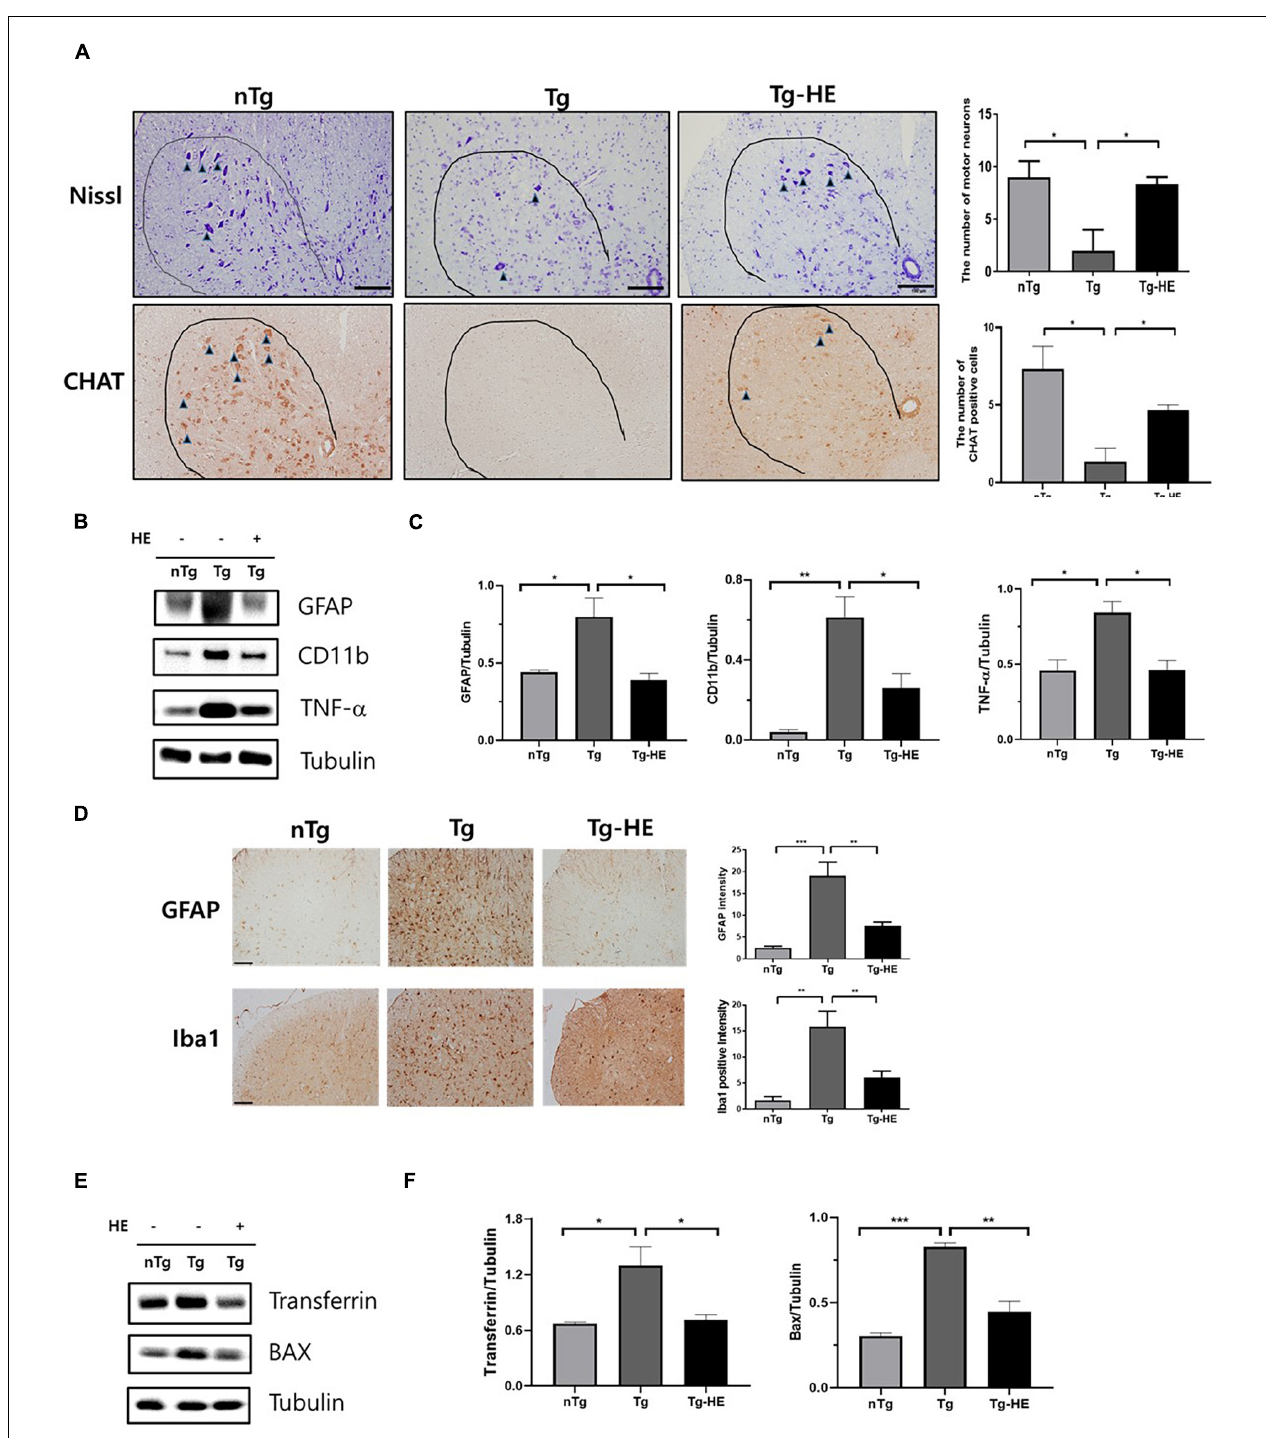
FIGURE 6 | Herbal extract (HE) inhibits motor neuron death and increases anti-neuroinflammatory and anti-oxidative effects. (A) Nissl staining of the motor neurons (arrowheads) in the anterior horn of L4-5 lumbar spinal cords ( N = 3); scale bar = 100 µ m. (B) Representative Western blotting images showing the expression of inflammation-related proteins [glial fibrillary acidic protein (GFAP), cluster of differentiation 11b (CD11b), and tumor necrosis factor (TNF)- α ] in the spinal cord of each group of mice ( N = 3). (C) Quantification of immunoblots normalized to the expression of tubulin. (D) Immunohistochemistry with anti-GFAP and anti-Iba1 in spinal cord. scale bar = 2 mm. (E) Representative Western blotting images showing the expression of transferrin and BAX in the spinal cord of each group of mice ( N = 3). (F) Quantification of immunoblots normalized to the expression of tubulin. Data are shown as the mean ± SEM. The statistical analyses were conducted with a one-way ANOVA followed by Newman-Keuls multiple or Bonferroni’s multiple comparison tests (* p < 0.05, ** p < 0.01, and *** p < 0.001).